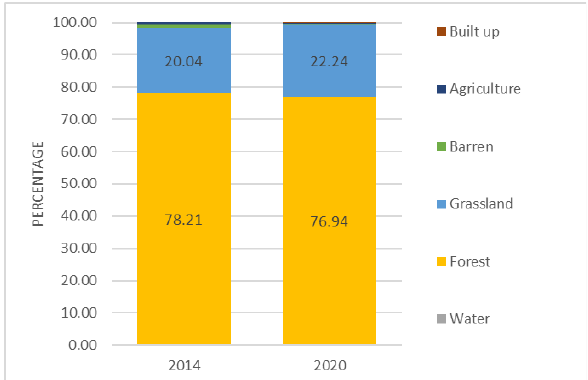
Figure 7. Estimated carbon stock contribution (percentage) of each LULC type in Pantangan-Carranglan